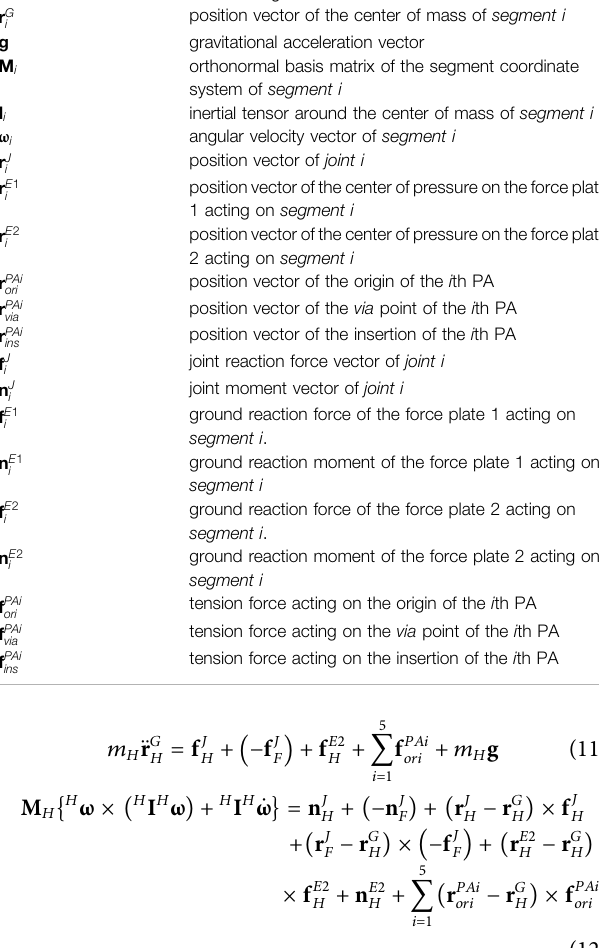
TABLE 2 | Notations in the equations of motion. segment or joint ID. P, F, and H represents phalanx, forefoot, and hindfoot segment, respectively. The i th joint is the proximal joint of the i th segment .